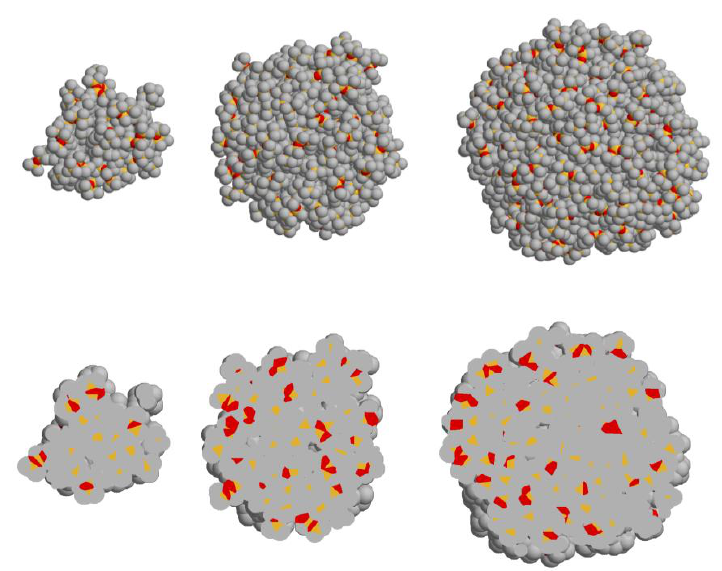
Figure 5. Molecular dynamics models of the 4th, 6th, and 7th generations of carbosilane-siloxane dendrimers. Top row: space-filling mode, bottom row: slab mode. dendrimers. Top row: space-filling mode, bottom row: slab mode.